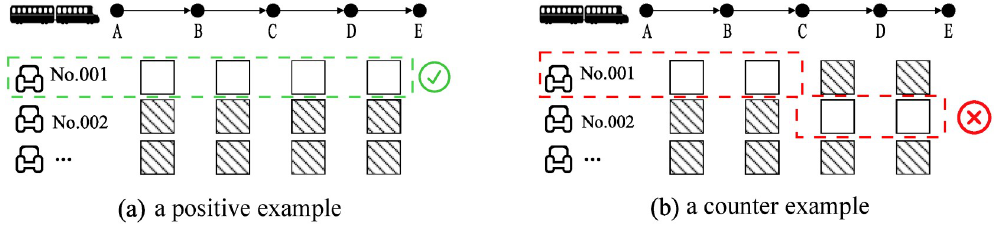
Fig 4. An illustration of joint seat